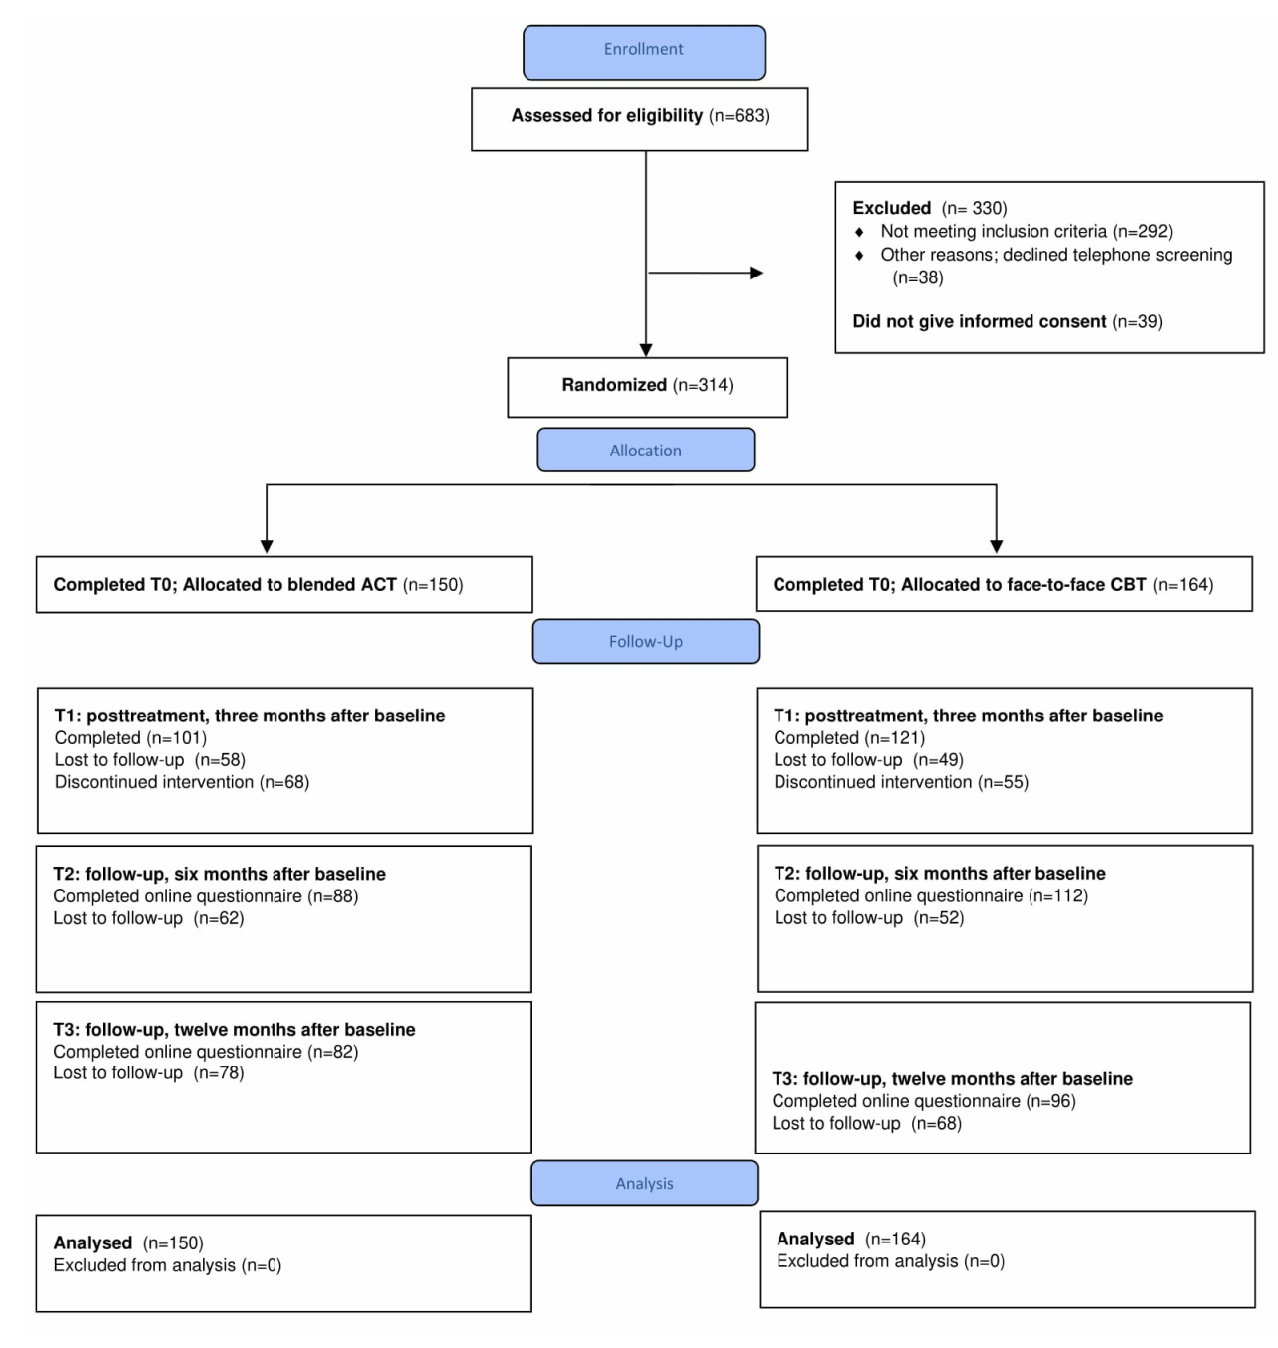
Fig 1. Flowchart of study